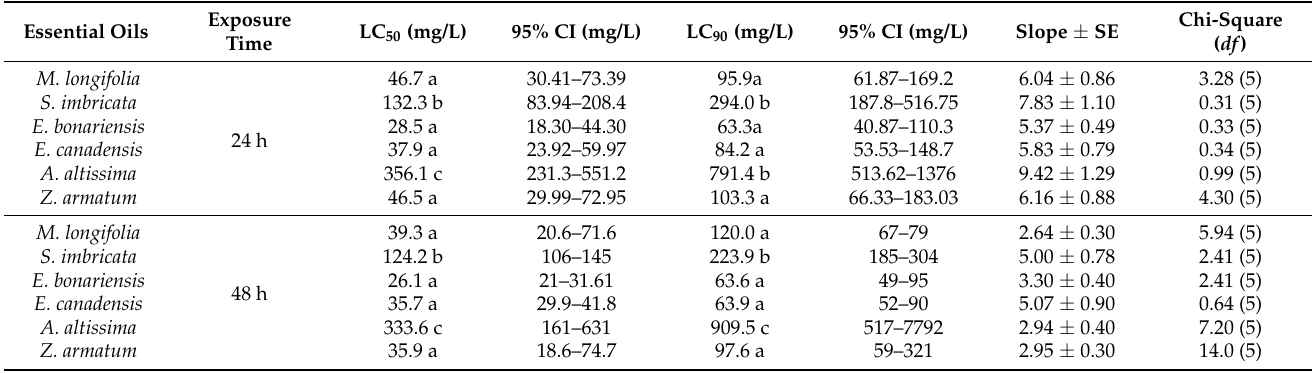
Table 2. Toxicity of essential oils tested against second-instar larvae of Aedes aegypti